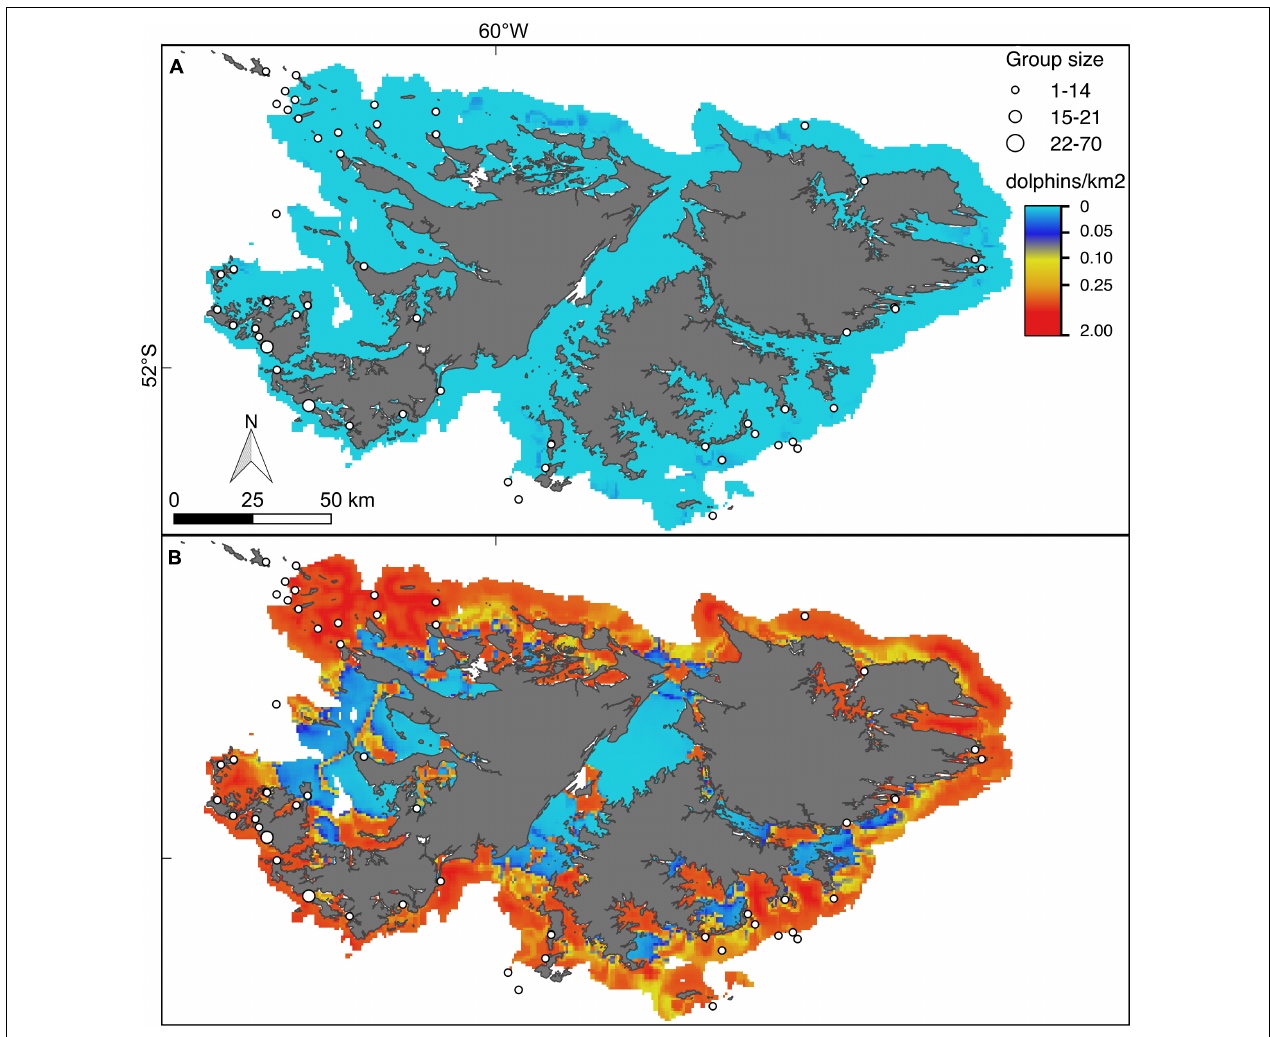
FIGURE 6 | Hurdle model lower (A) and upper (B) bounds of the 95% confidence interval for the predicted density (dolphins/km 2 ) of Peale’s dolphins. For further explanation see Figure 4